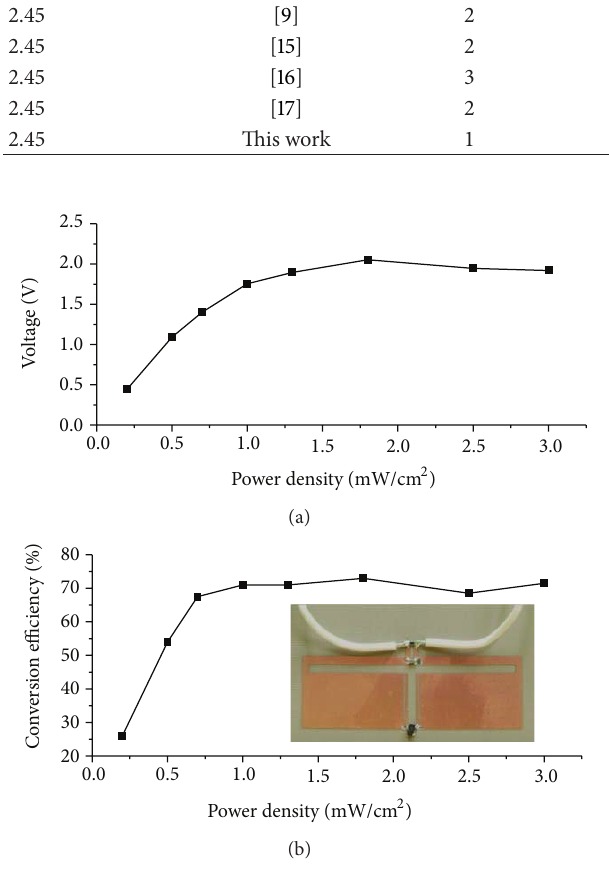
Figure 11: (a) Measured DC output voltages and (b) calculated conversion